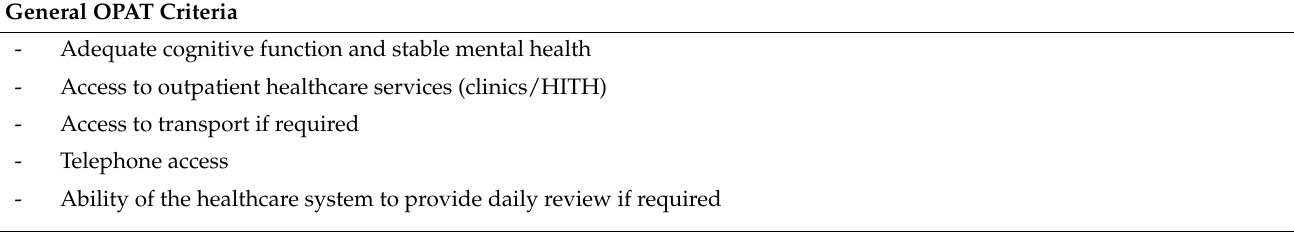
Table 2. Patient Selection for